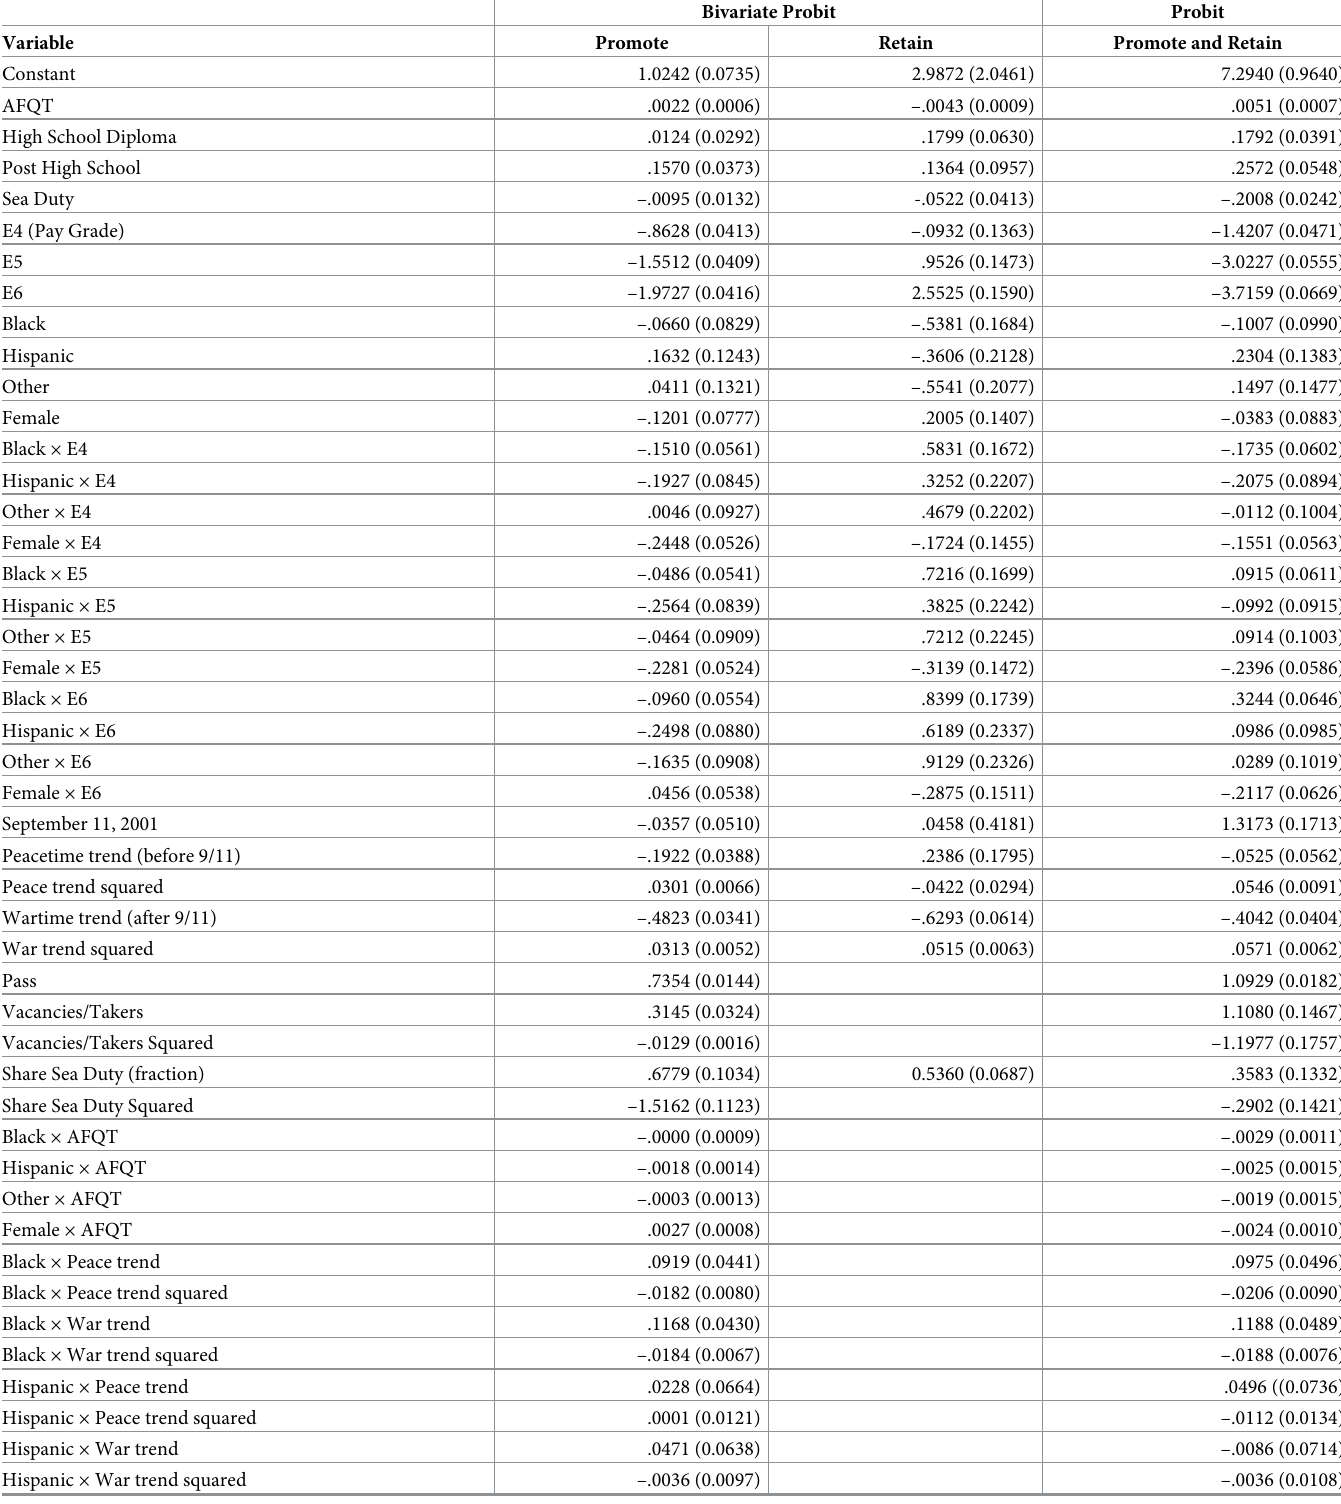
Table 1. Bivariate and probit estimation results for